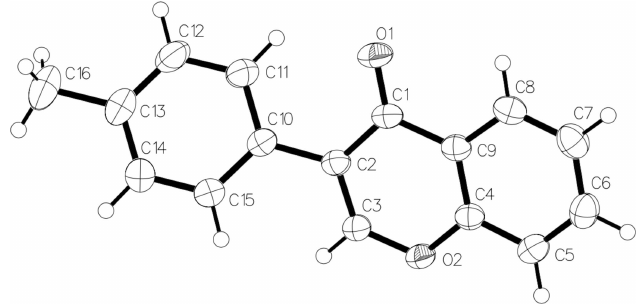
Figure 1 The molecular structure of the title compound with displacement ellipsoids drawn at the 30% probability